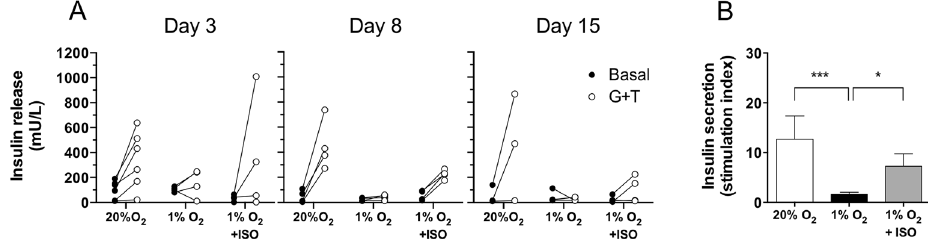
Figure 5. Function of neonate pig islets (NPIs) in O 2 balanced BAPs. Alginate encapsulated NPIs (3000 IEQ/150 µL) were cultured for 3, 8, and 15 days under 20% O 2 (positive control, white bar) or 1% O 2 conditions without the O 2 strategy (1% O 2 , negative control, black bar), or with the innovative strategy of oxygenation (ISO) composed of silicone-CaO 2 disk and 500 µg/mL HEMOXCell by alginate (1% O 2 + ISO, grey bars). ( A ) Glucose plus theophylline (G + T) responsive insulin release by 30 min sequential incubations of alginate encapsulated NPIs in basal medium (close circle) and glucose plus theophylline stimulation (open circle) after 3, 8 and 15 days of culture. ( B ) Stimulation indexes (ratio of high glucose plus theophylline stimulation over basal insulin secretion) of alginate encapsulated NPIs after 3, 8, and 15 days of culture. Results from independent experiments (n = 4–6) are expressed ( A ) individual results matched in basal or stimulation media or as ( B ) mean ± SEM. * p < 0.05, ***p < 0.005 (Mann–Whitney